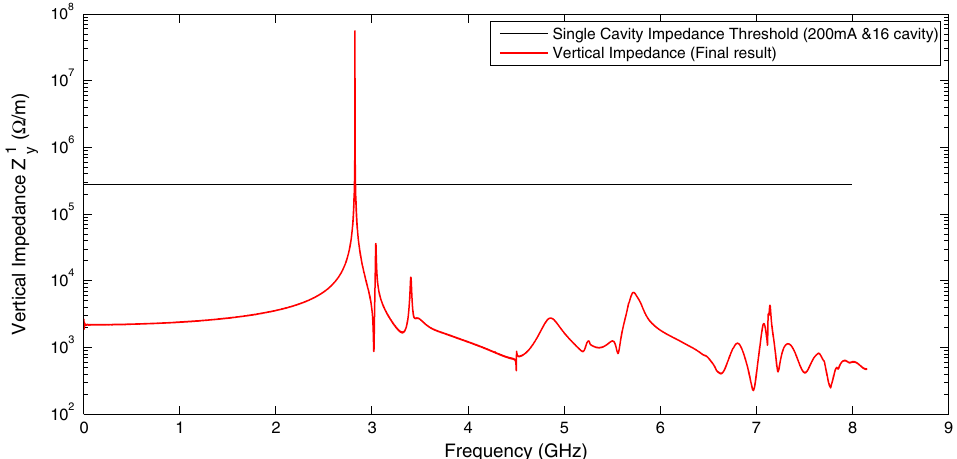
FIG. 14. Single-cavity fully resolved vertical wake impedance Z 1